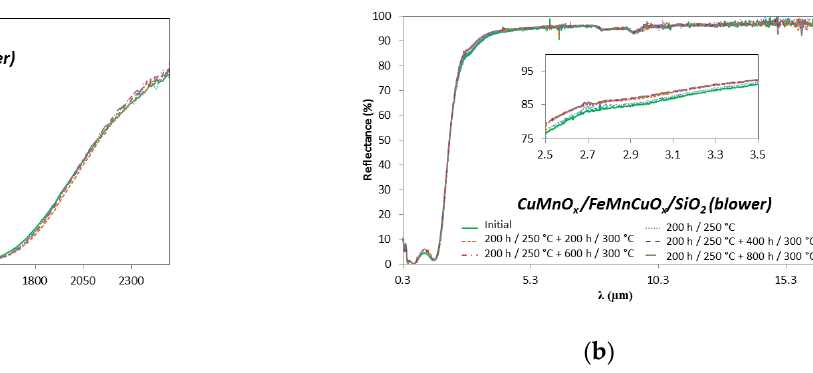
Figure 8. Hemispherical reflectance spectra of Al/CuMnO x /CuFeMnO x /SiO 2 (blower) samples, before and after each ageing stage of the thermal stability test ( a ) in the solar wavelength range; ( b ) from 0.3 to 17 µm. Amplification between 2.5 and 3.5 µm (inset).